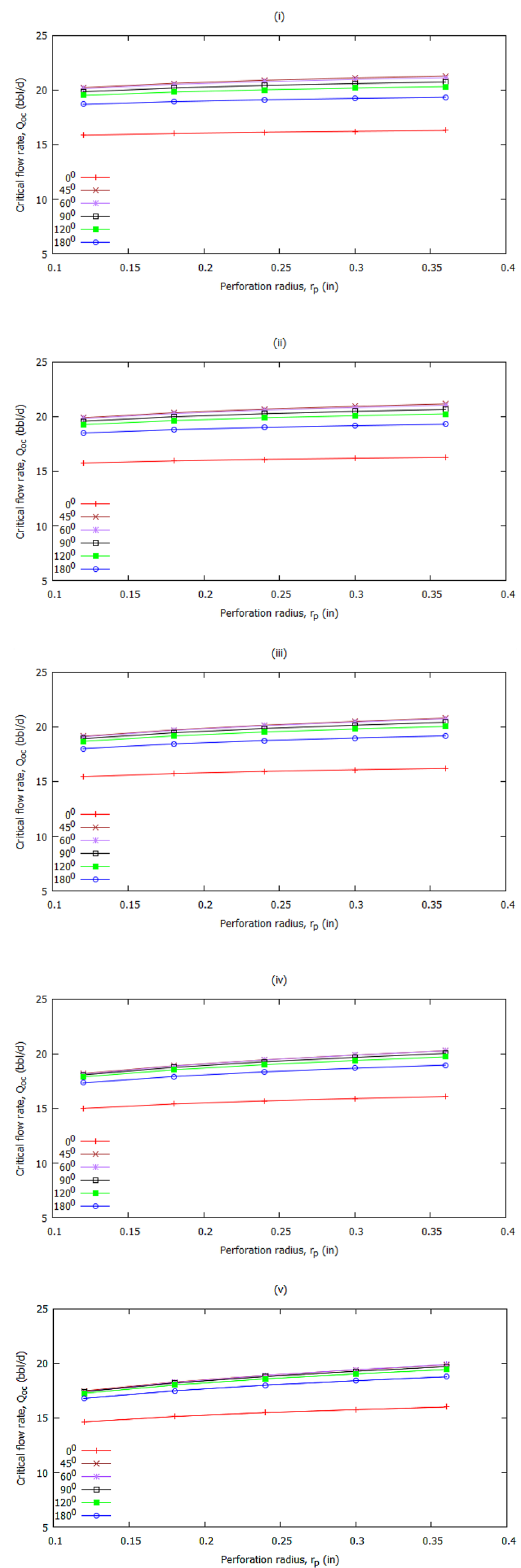
Fig. 6 Perforation length of 30 in and spacing between perforations on critical flow rate at different phasing angles and perforation